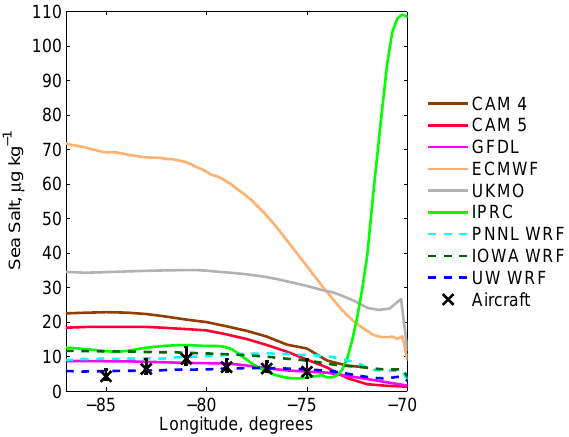
Figure 10. Mean sea-salt aerosol dry mixing ratio along 20 ◦ S (µgkg − 1 ) compared with C-130 particle counter and Giant Nuclei Impactor measurements from Blot et al. (2013).